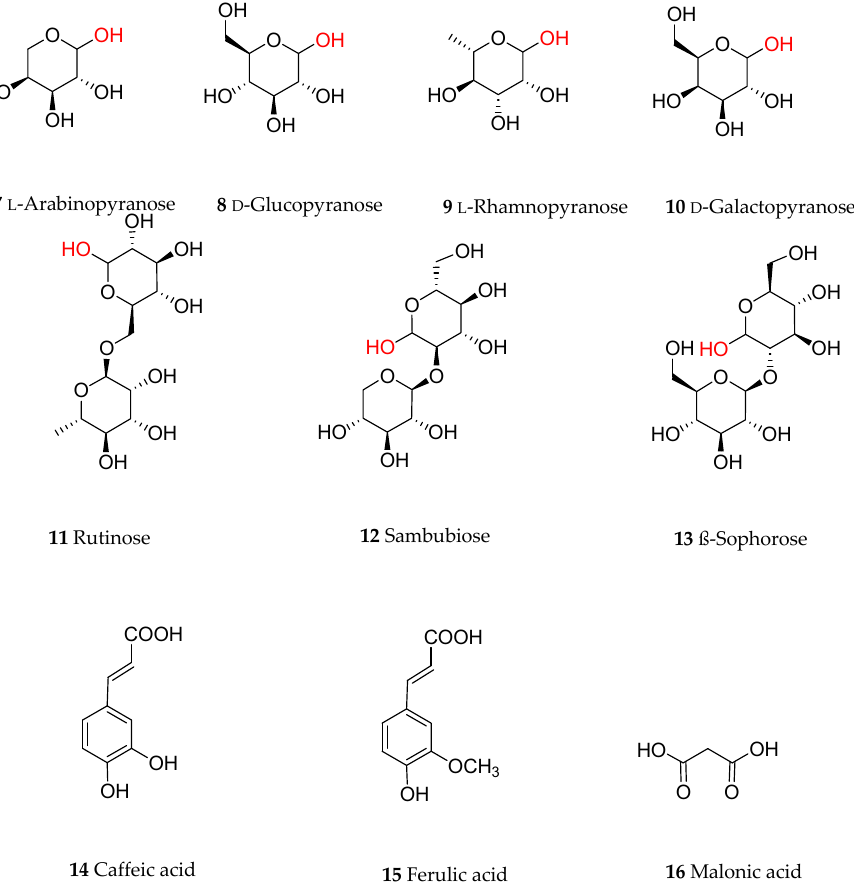
Figure 1. The common flavonoid skeleton as exemplified by quercetin and the anthcyandins.